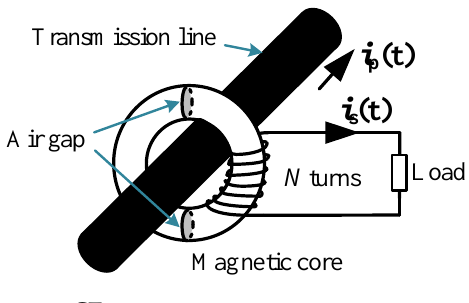
Figure 1. CT setup. Figure 1. CT setup.